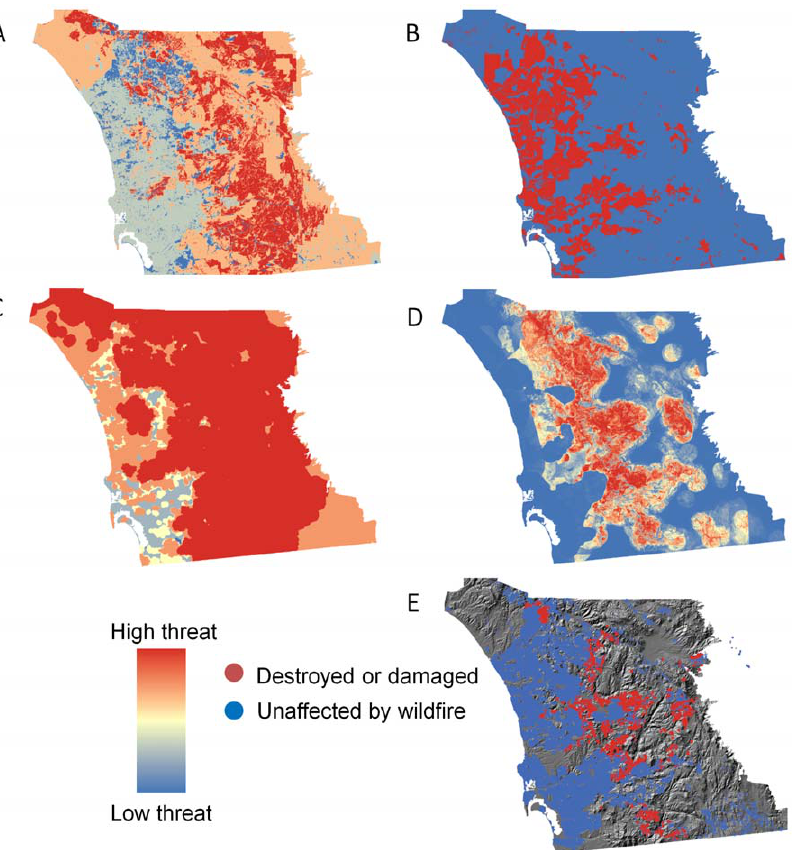
Figure 6. Fire hazard maps versus actual burned structures in San Diego County. (A) CDF ‘‘Fire threat’’ (B) CDF ‘‘Communities at risk’’ (C) CDF ‘‘Fire threat to people (D) Empirically based map showing probability of structure being burned by fire (E) Structures that were destroyed or damaged (red) and unaffected (blue) by wildfire from 2001–2010. CDF – California Department of Forestry and Fire Protection.